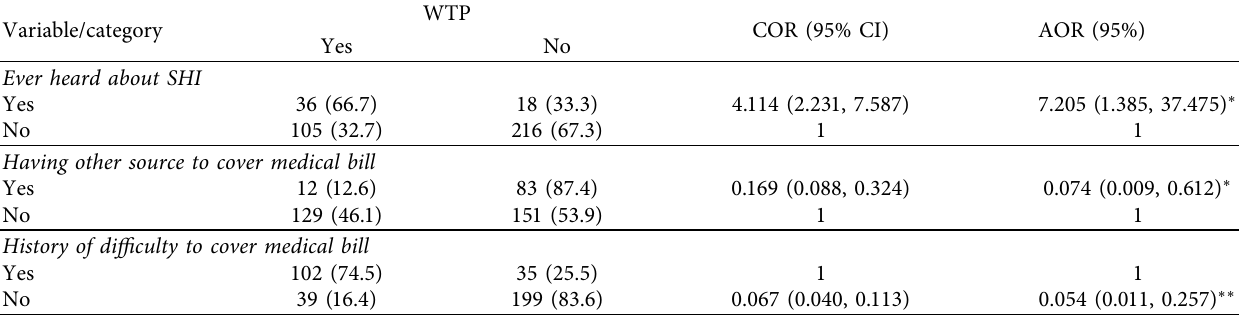
Table 5: Factors associated with willingness to pay for SHI among government employees in Muja town, northeast Ethiopia, 2016 ( n � 375).